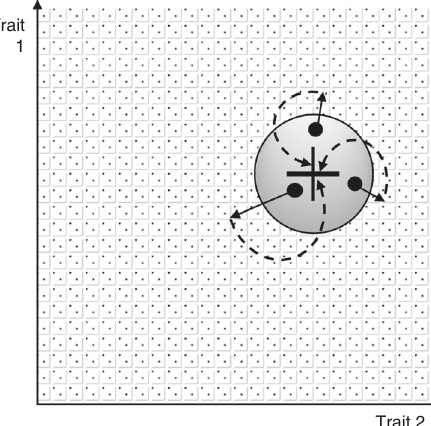
Fig. 6 Sel fi sh genetic elements evolve to be suppressed by the parliament of genes. The cross represents the position in phenotype space, here de fi ned with respect to two traits, 1 and 2, that maximises the fi tness of an individual. The circle surrounding the cross represents the phenotype space where suppression of sel fi sh genetic elements, that have distorted traits 1 or 2, would not be selected for. The surrounding area represents the phenotype space in which the parliament of genes is selected to suppress sel fi sh genetic elements. The three dots represent three possible individuals, each with differently weakly sel fi sh genetic elements, which incur a small fi tness cost. Because these deviations from individual fi tness maximisation are only slight, costly suppression of the weakly sel fi sh genetic elements does not evolve. However, the sel fi sh genetic elements will evolve to become more distorting (solid arrows), bringing individuals into the area of phenotype space where they will be suppressed and individual fi tness maximisation (the black cross) is regained (dashed